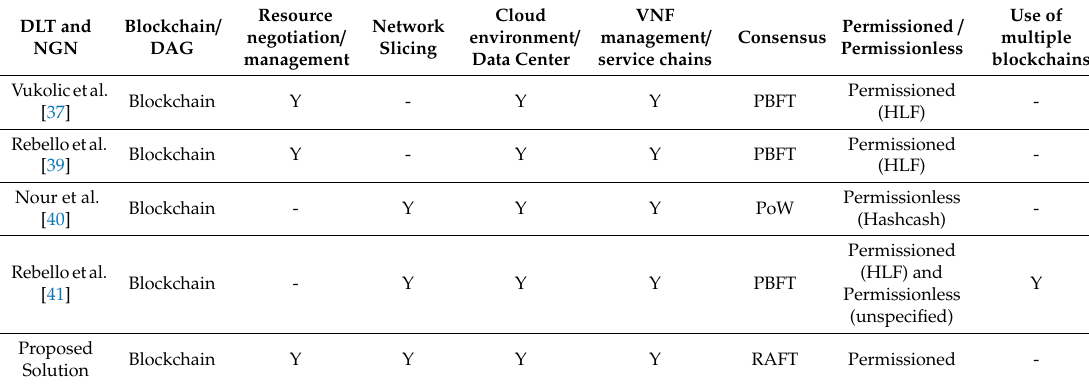
Table 2. Current studies and ideal